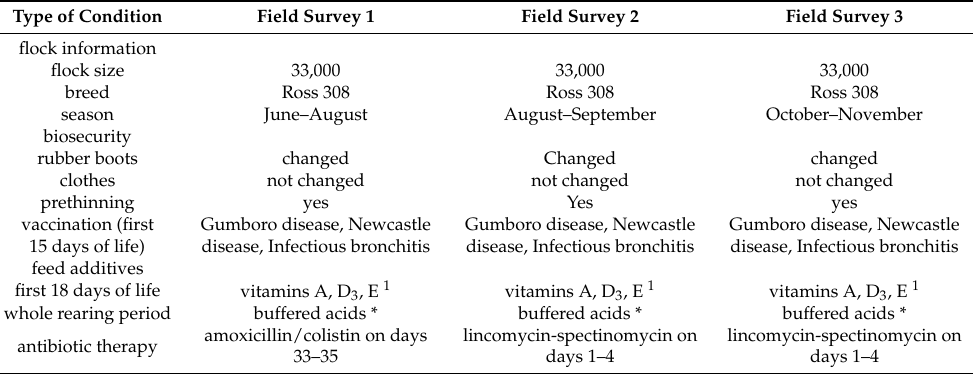
Table 1. Rearing conditions during field surveys: detailed conditions used in the three field surveys including flock information, biosecurity, feed additives used, and antibiotic